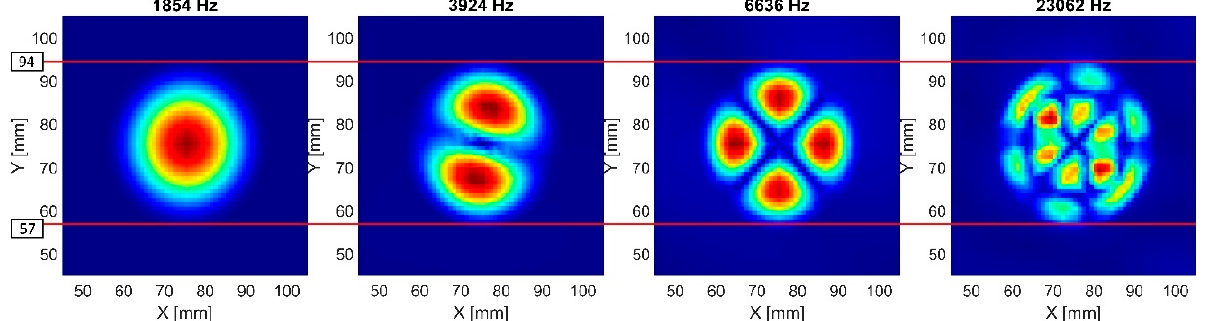
Figure 12. Comparison of the diameter of FBH Ø40 mm based on di ff erent LDR